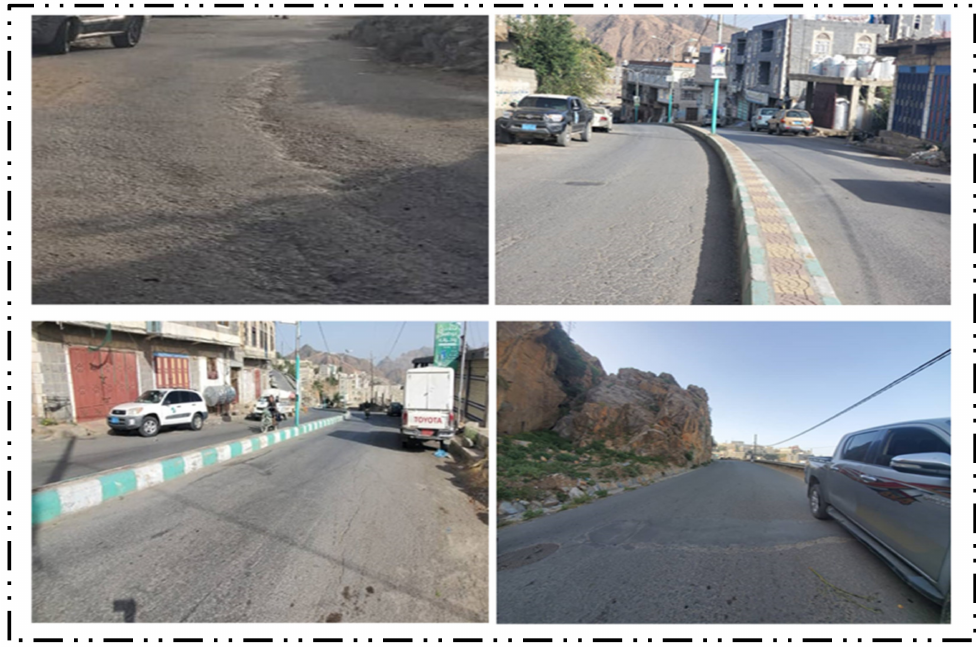
Figure 1. The road segment